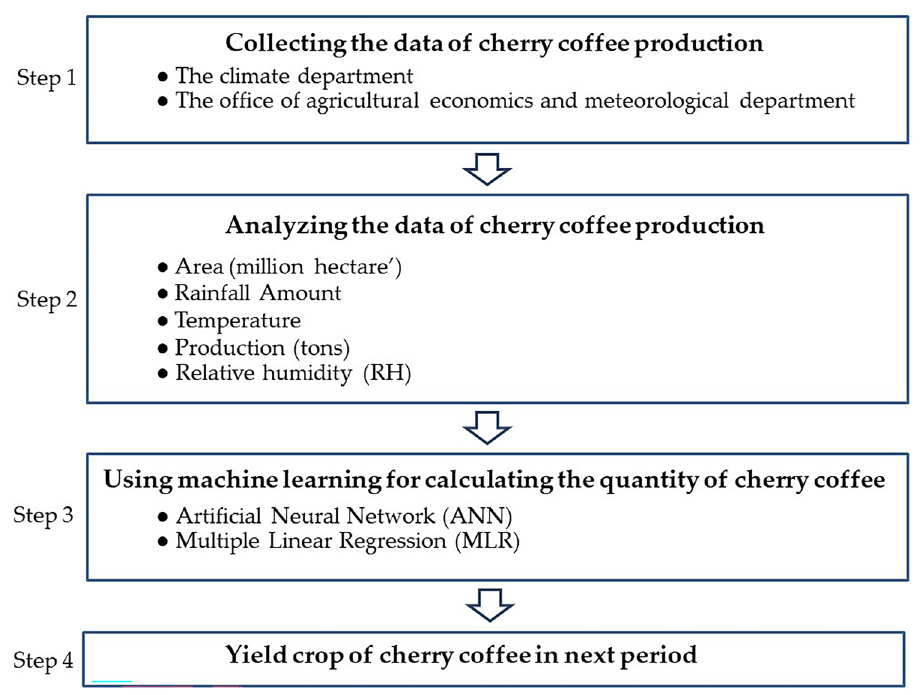
Figure 7. Research framework for cherry coffee